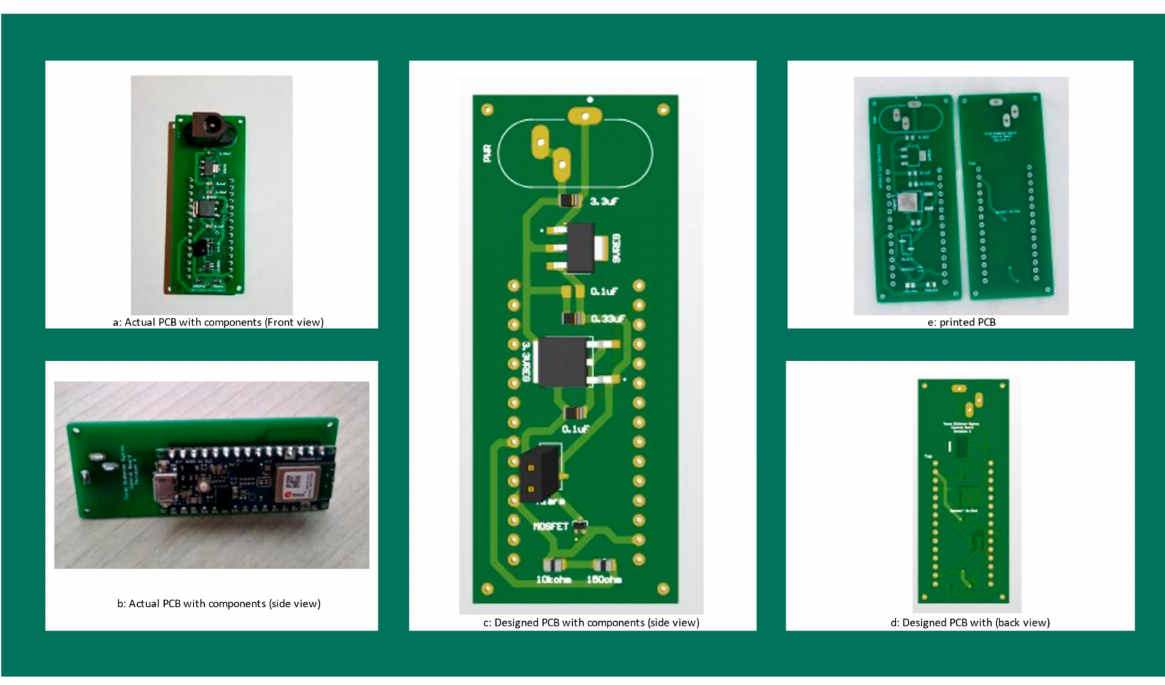
Figure 10. DiAtack